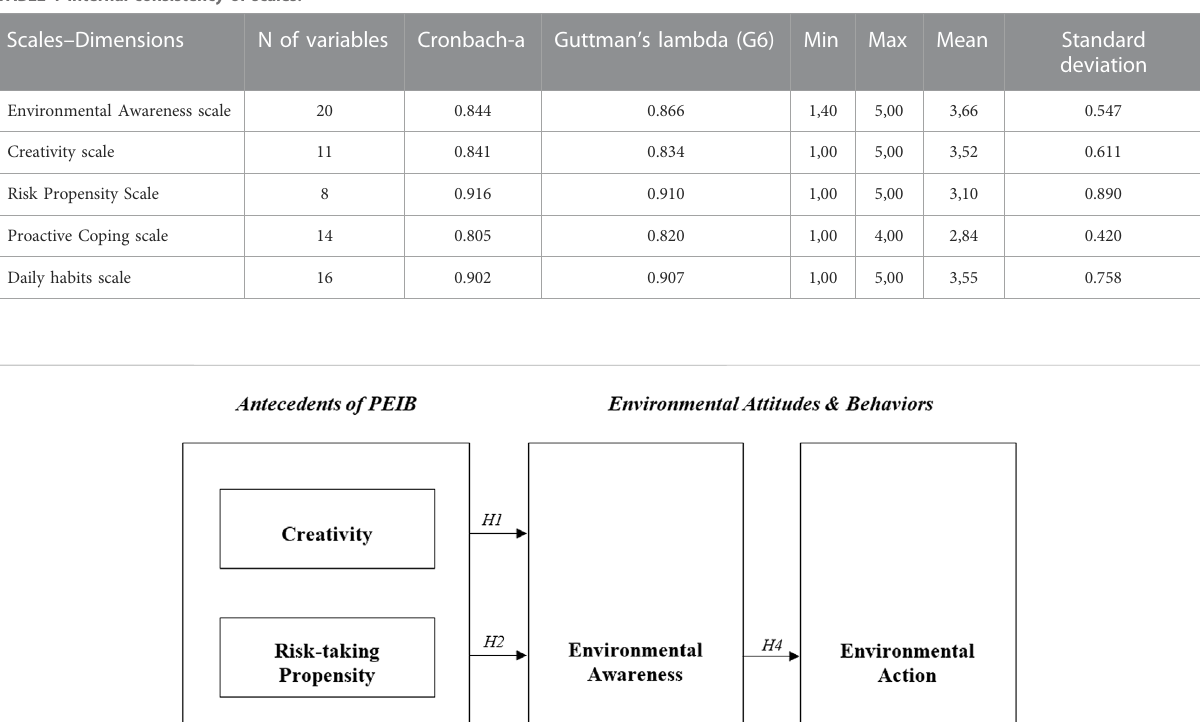
TABLE 1 Internal consistency of scales.